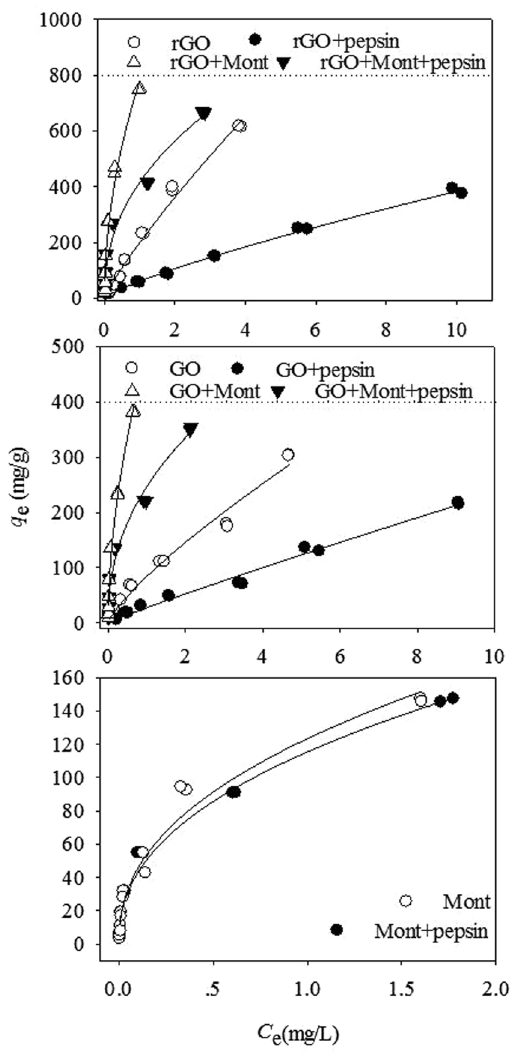
Figure 2. Adsorption of CIP on GO, rGO and Mont under the varying interaction system at pH 2. The solid line is Freundlich